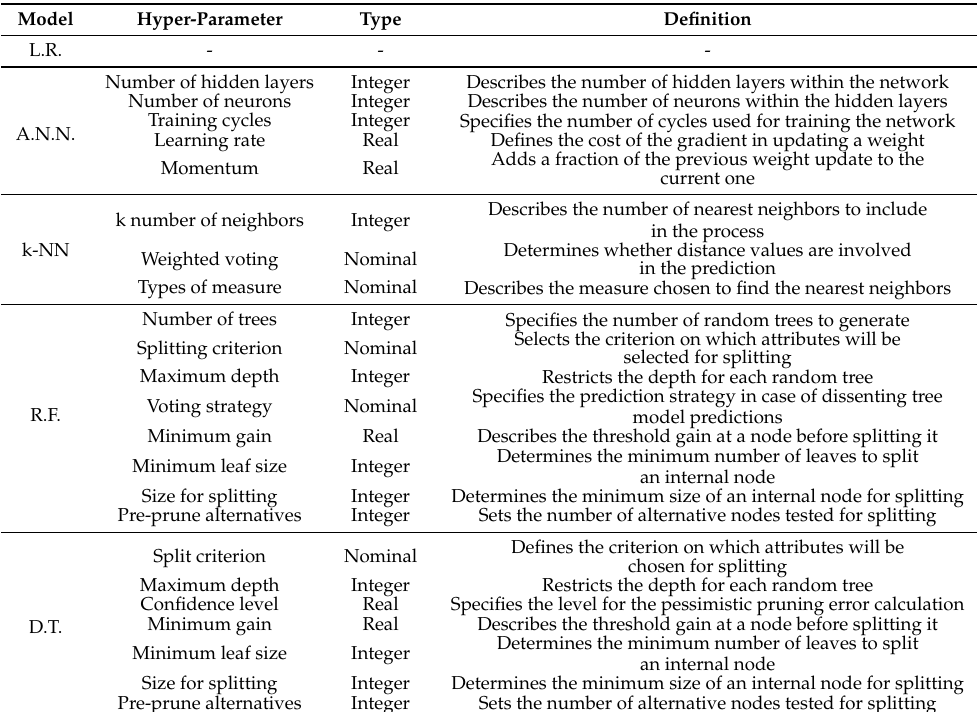
Table 2. Definition and types of hyper-parameters for parametric and nonparametric